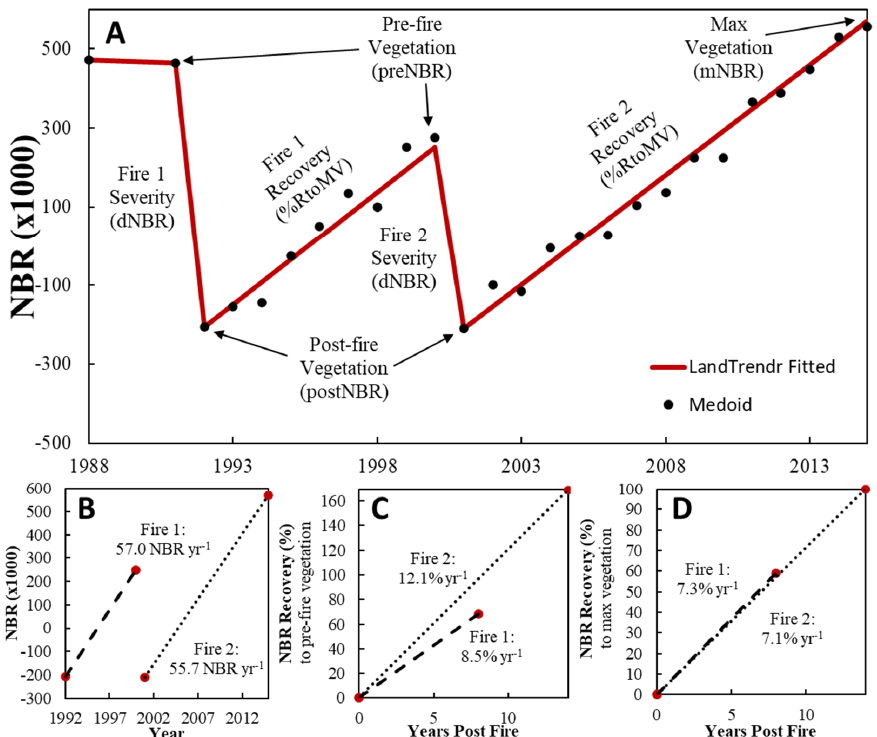
Figure 4. Conceptual model outlining LandTrendr and the quantification of burn severity ( dNBR ) and recovery (%RtoMV ). ( a ) LandTrendr fitted and medoid NBR values for an example pixel that experienced fires in the 1992 and 2001 seasons. ( b – d ) Comparison of methods to quantify post-fire recovery for a multi-burn pixel. ( b ) Fitted NBR slope. ( c ) NBR recovery (%) to preNBR [16]. ( d ) NBR recovery (%) to the maximum amount of vegetation for that pixel in the time-series ( mNBR